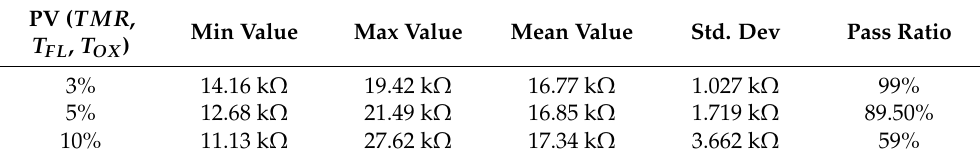
Table 3. Results of 200 Monte-Carlo simulations for average MTJ resistance value under various PVs. PV ( TMR , Min Value Max Value Mean Value Std. Dev T FL , T OX ) 3% 14.16 k